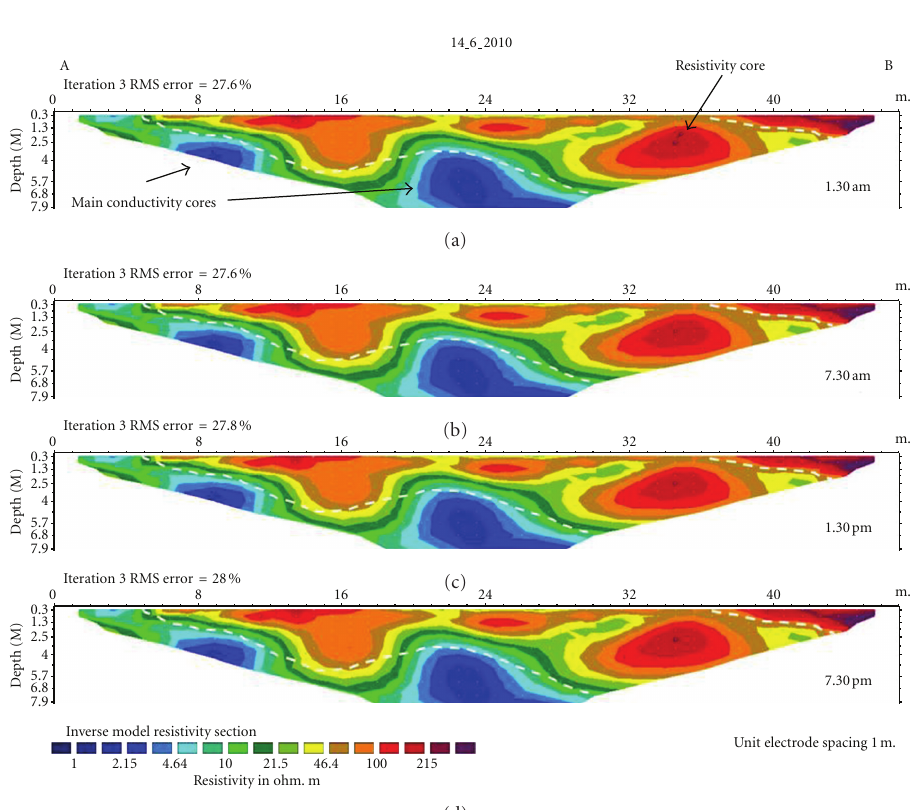
Figure 9: ERT related to the 15/05/2010 daily cycle of acquisition.